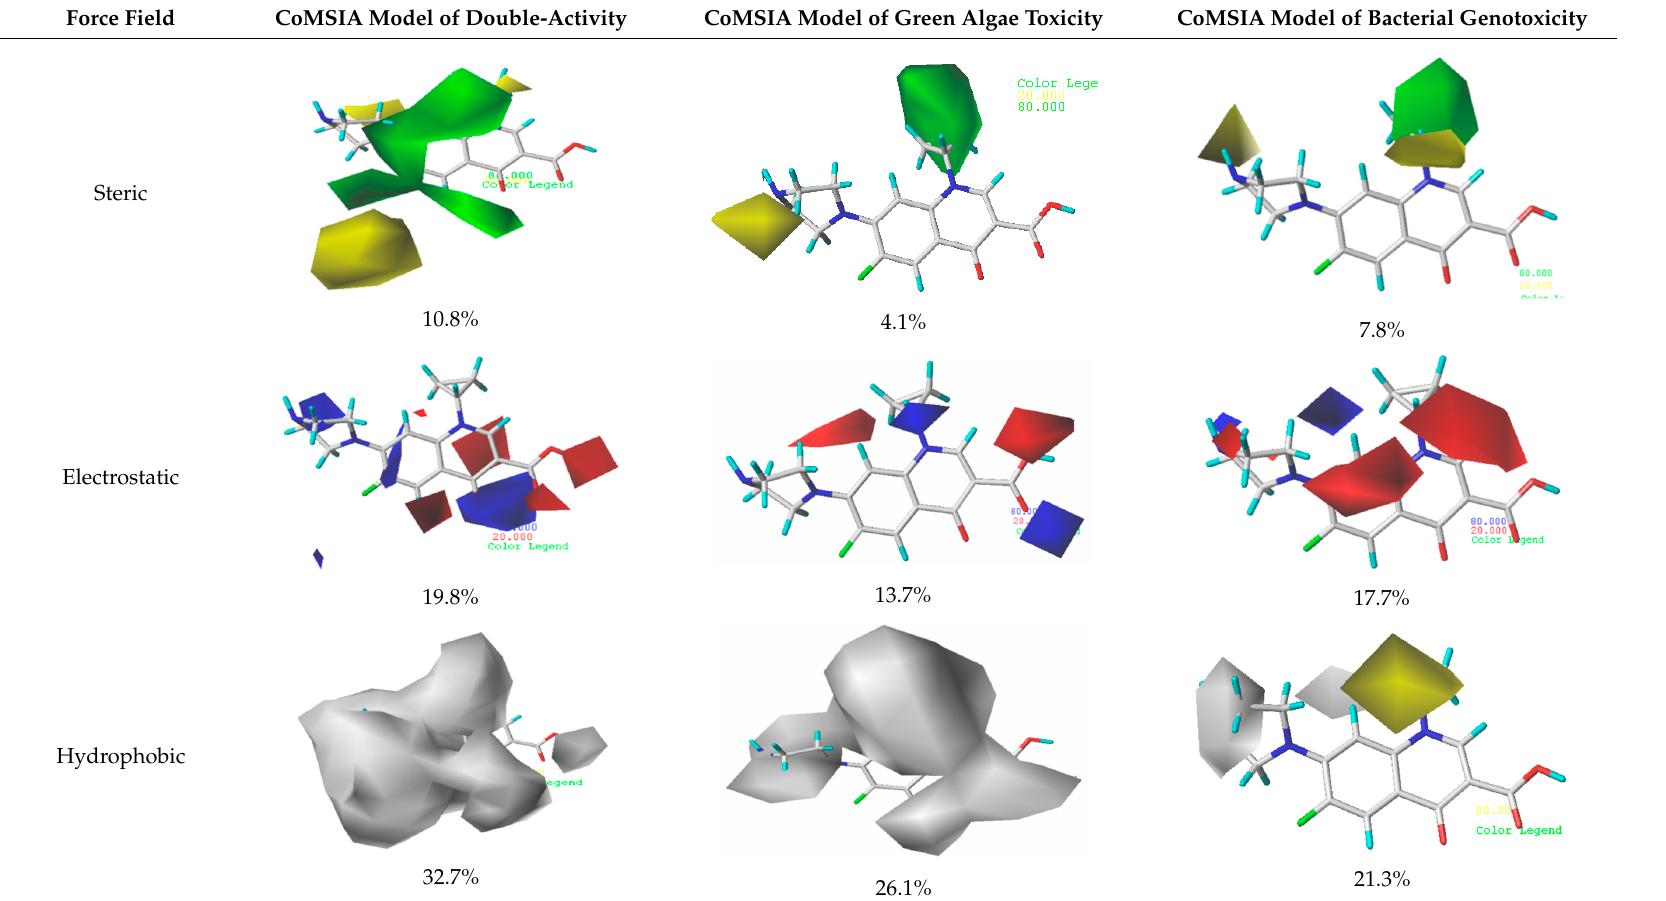
Table 8. The contour maps of the CoMSIA models for both the single activity and double activities of green algae toxicity and bacterial genotoxicity.